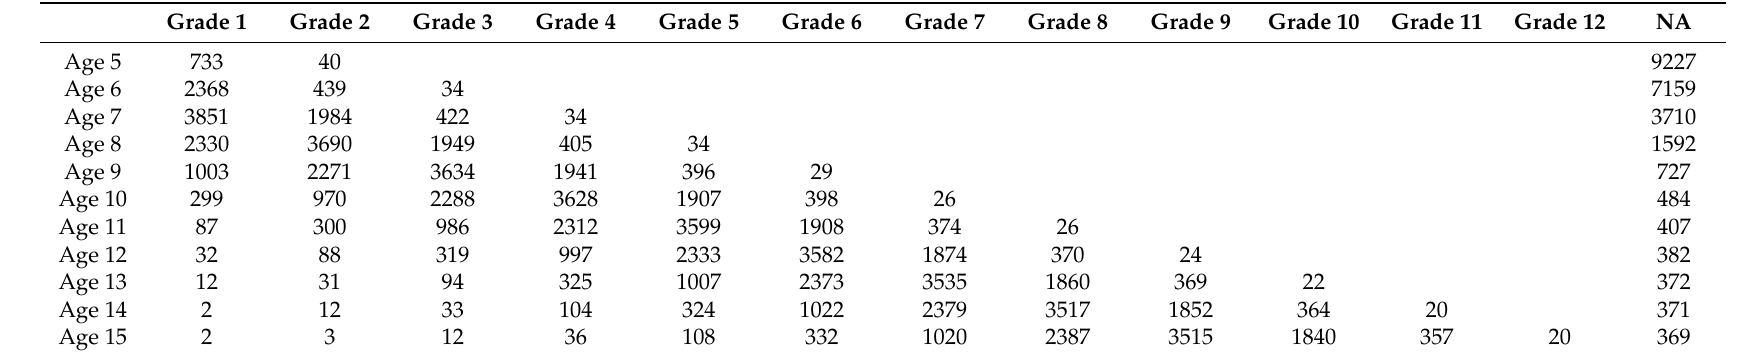
Table A9. Grade transition in electrified areas